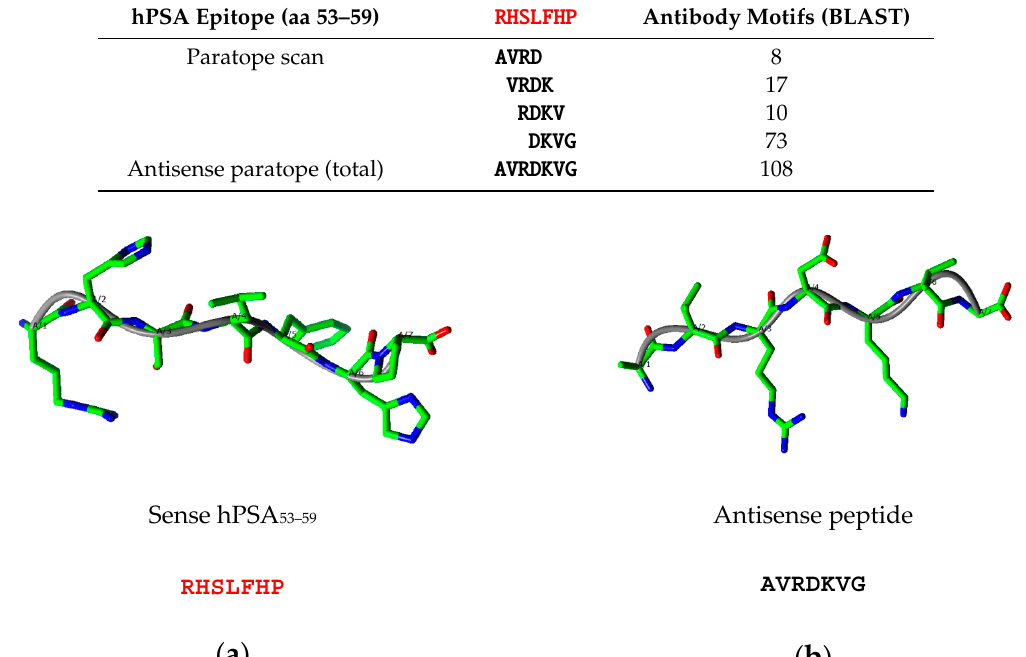
Table 3. The antisense peptide sequence AVRDKVG was obtained by joining four paratopes one by one. The paratopes motifs were selected on the basis of the highest number of antibody homologies detected by the Basic Local Alignment Search Tool (BLAST) [ 45 ] .